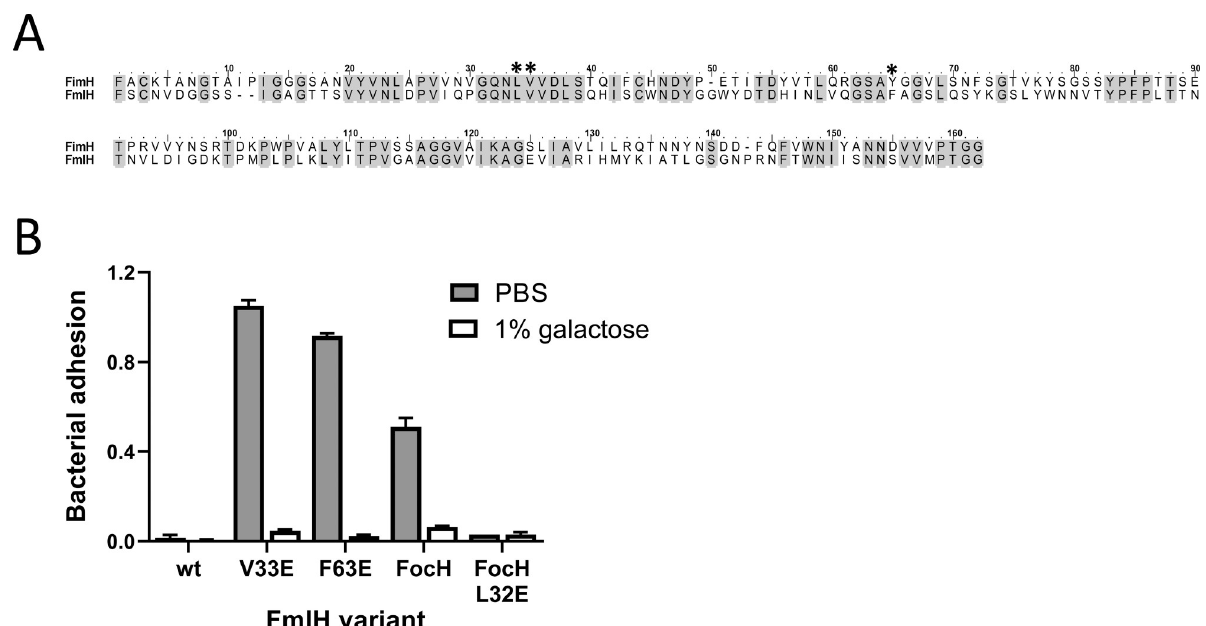
Fig 8. Toggle switches are conserved in the FimH homologue, FmlH adhesin. (A) Sequence alignment of FimH and FmlH lectin domains with L34/V35- and Y64-switches marked by asterisks. Identical residues are gray-shadowed. (B) Adhesion mediated by mutant variants of FmlH adhesin in the absence and presence of 1% galactose to surface-coated asialofetuin. Data are mean absorbance values at 600 nm ± SD, n = 1 representative